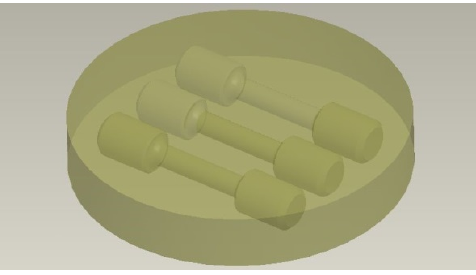
Figure 4. Location of the three tensile test pieces machined from within sintered discs (60 mm in diameter and 10 mm in thickness).